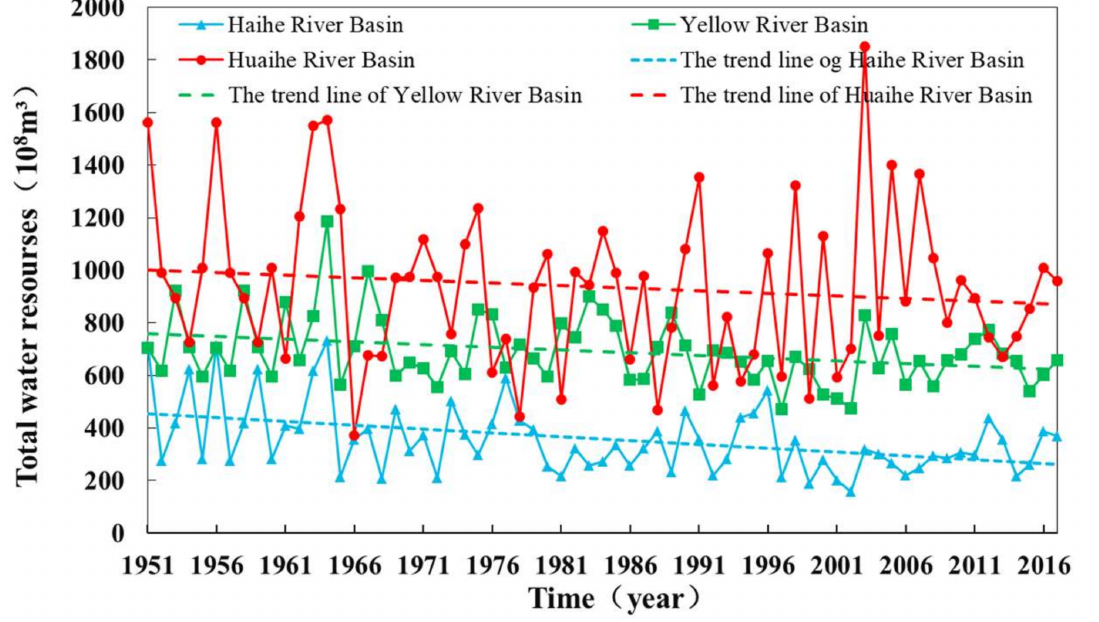
Figure 2. The total water resources of the three first-level regions in the Huang-Huai-Hai River Basin during